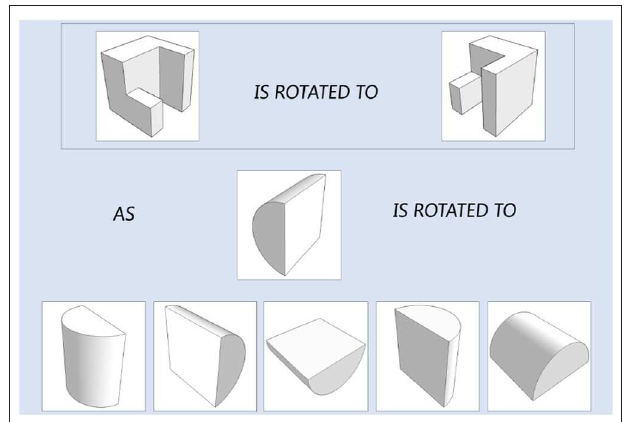
FIGURE 2 | The 3D model for the objects/figures in an